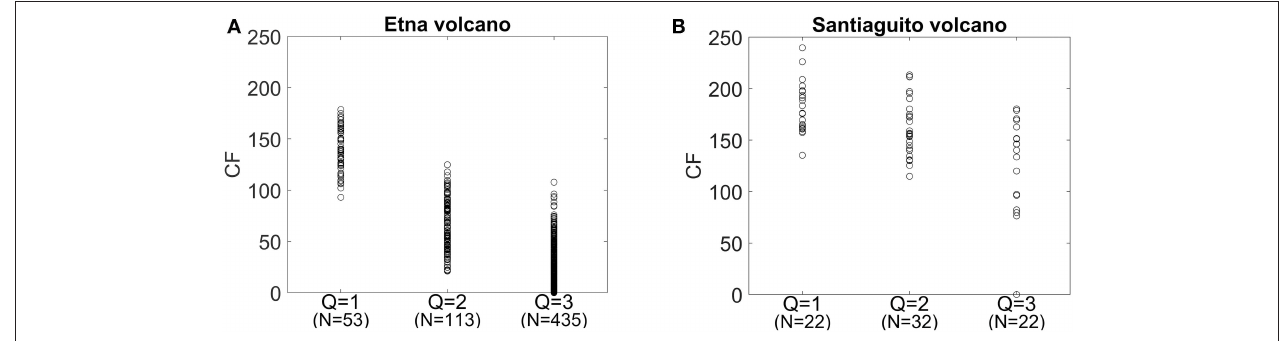
FIGURE 6 | Values of the characteristic function in the VINEDA algorithm for Etna (A) and Santiaguito (B) volcanoes, for the events manually assessed by the experts with the three different quality criterion considered: “strongly agree” (Q = 1), “agree” (Q = 2), and “undecided” (Q = 3). N indicates the total number of detected explosions by the algorithm with the assigned quality